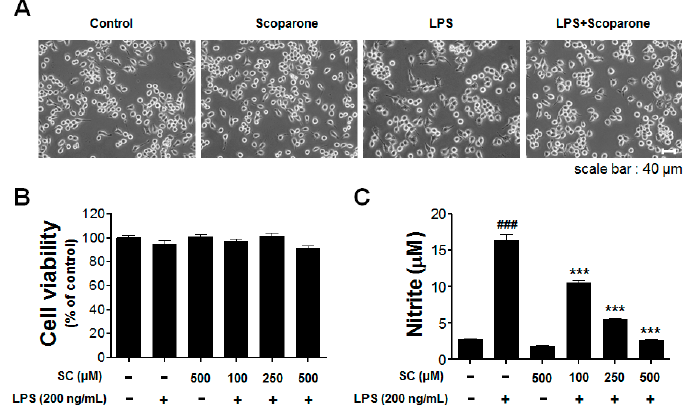
Figure 1. Effect of scoparone on cell viability and nitric-oxide production in LPS-induced BV-2 microglial cells. The morphological changes are represented in the BV2 microglial cells ( A ). The viability in the scoparone-treatment cells was evaluated using the MTT assay ( B ). The BV-2 microglial cells were incubated with 100 μ M, 250 μ M, and 500 μ M of scoparone for 24 h. The results are displayed as a percentage of the control samples. The nitrite in the medium was determined using the Griess assay ( C ). Data are the mean ± standard error ( n = 3) of three independent experiments. ### p < 0.005, compared with the control group; *** p < 0.005 compared with the LPS-treated group.